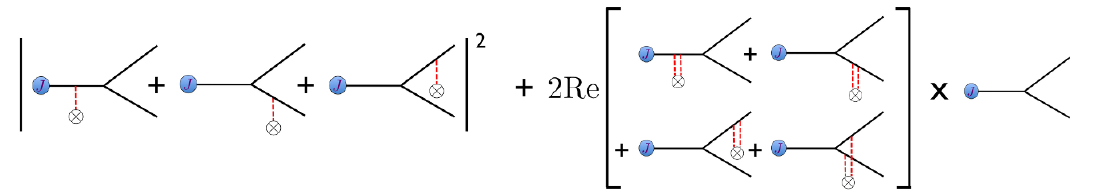
Figure 2 . Single- and double-Born Feynman diagrams that contribute to the massive in-medium splitting functions to (cid:12)rst order in opacity. The topology is the same for all three splitting processes Q ! Qg , Q ! gQ and g ! Q (cid:22) Q . Figure adapted from